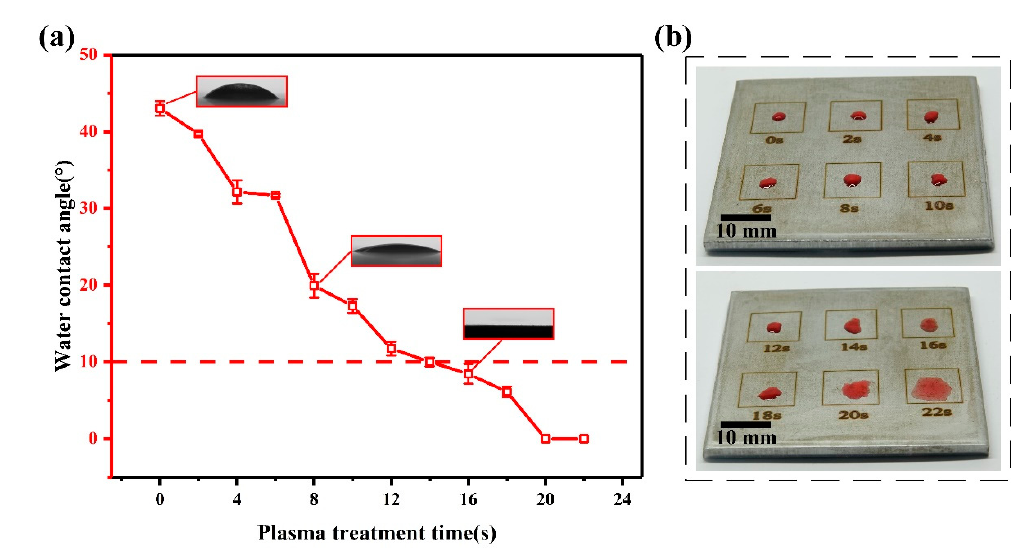
Figure 5. Test results of surface wettability of pure iron with atmospheric pressure plasma treatment (APPT) treatment: ( a ) change rule of water contact angle at plasma treatment time, ( b ) state of liquid drop on pure iron surface.